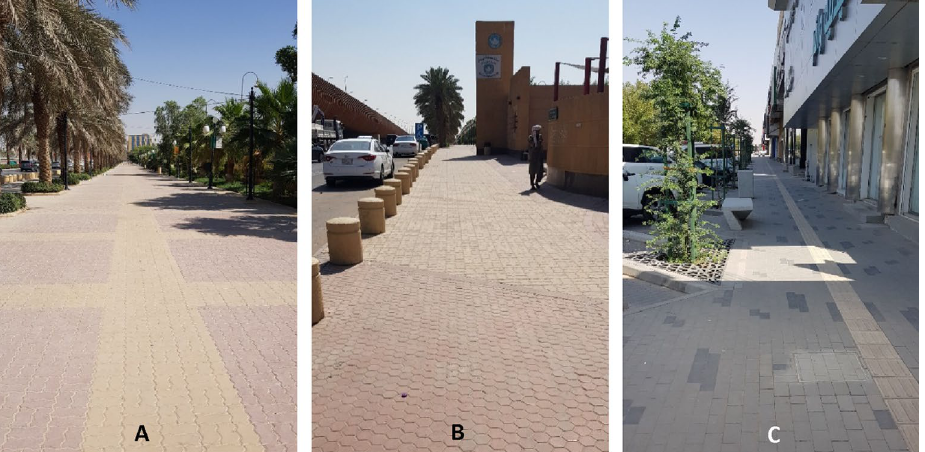
Figure 7. Examples for the street status “good for mobility” of type P, where ( A , B ), and ( C ) are for location points 4, 5, and 11, respectively (See Fig. 5).